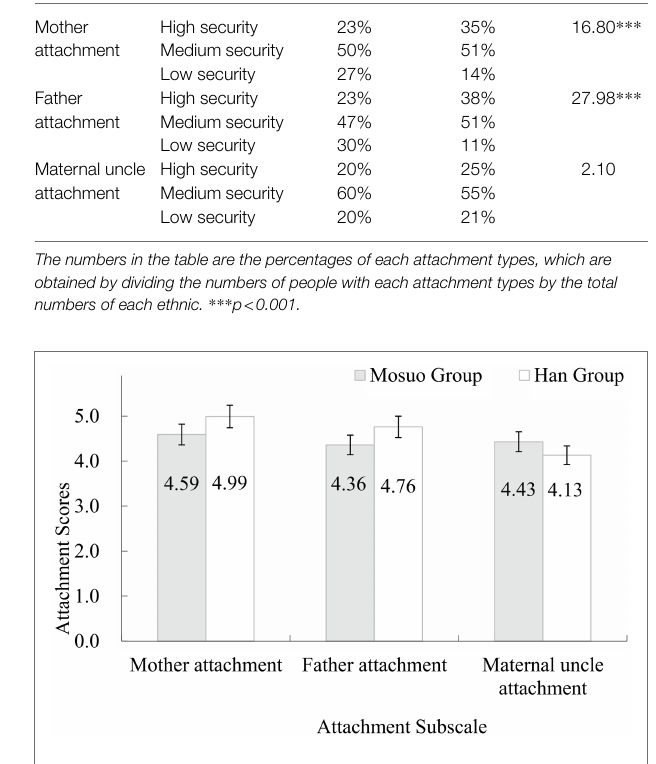
FIGURE 1 | Average scores of the three attachment subscales between Mosuo Group and Han Group in Study 1. Error bars represent 95%